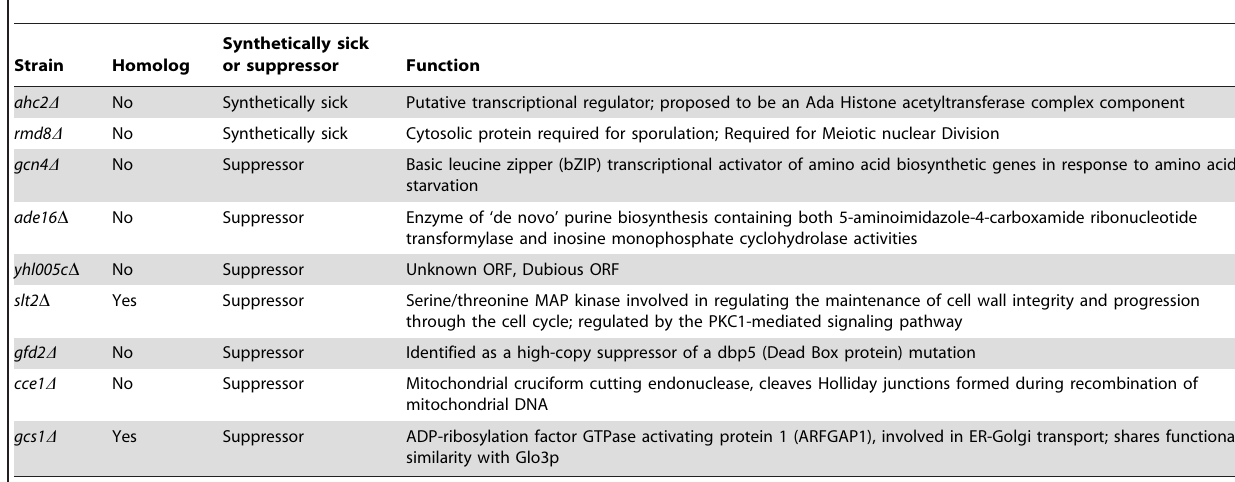
Table 1. Yeast deletion strains synthetically sick with truncated LRRK2 or suppressors of the toxicity induced by truncated LRRK2.